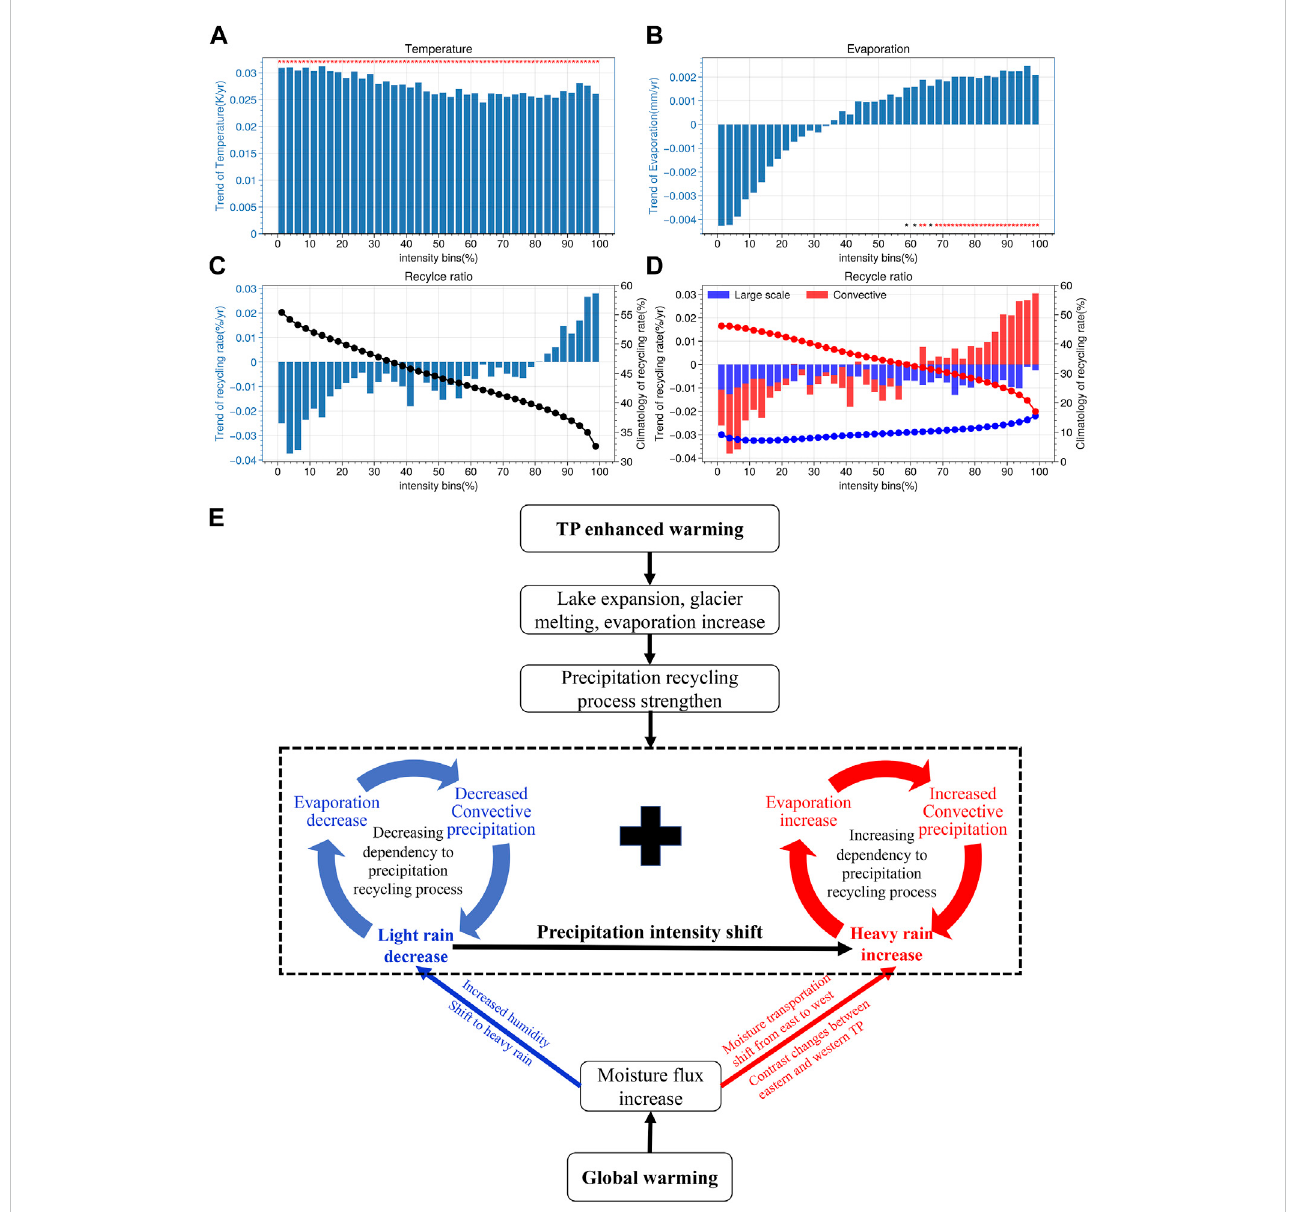
FIGURE 8 Distribution of trends (bars) in precipitation percentile intensity bins of temperature, evaporation, and recycling ratio during the summer of 1979 – 2019 over the TP and the schematic illustration. Bars show the linear trends of temperature (A) , evaporation (B) , precipitation recycling ratio (C) and precipitationrecyclingratiocorrespondingtoconvectiveandlarge-scaleprecipitation (D) .Theblacklinein fi gurecshowstheclimatologyoftheprecipitation recycling ratio. The red line and blueline in d show the climatology of theconvective precipitation recycling ratio and large-scale precipitation recycling ratio,respectively.In (E) theschematicillustrationofhowprecipitationrecyclingchangesin fl uencetheshiftofprecipitationintensityovertheTP.Theredstars and black stars indicate statistical signi fi cance exceeding 95% and 90%,